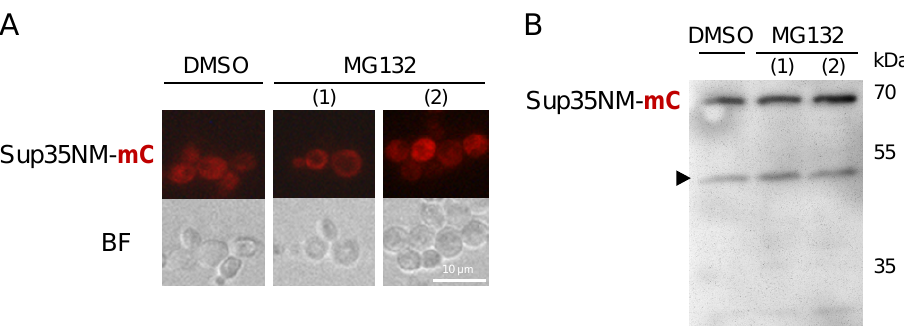
Figure 6. Proteasomal degradation is not responsible for the Sup35NM-mCherry processing and diffuse distribution in [ PSI + ] cells. OT56 cells expressing SUP35NM-mCherry under control of CUP1 promoter were treated with MG132 for 4 hours; DMSO treatment was used as a control. MG132 was either added simultaneously with CuSO 4 (1) or one hour prior to CuSO 4 addition (2). Cells were analyzed with fluorescence microscopy ( A ) or were subjected to protein extraction and Western blotting ( B ). Anti-Sup35NM antibodies were